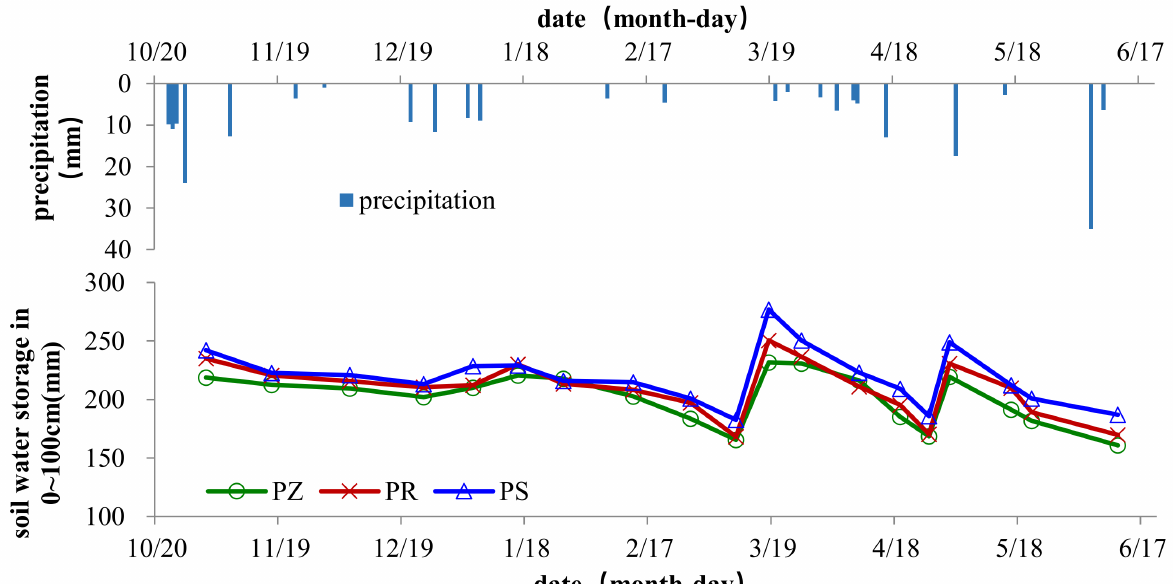
Figure 4. Changes of soil water storage at 0~100 cm under different tillage methods (2017). PZ, no tillage; PR, rotary tillage; PS,